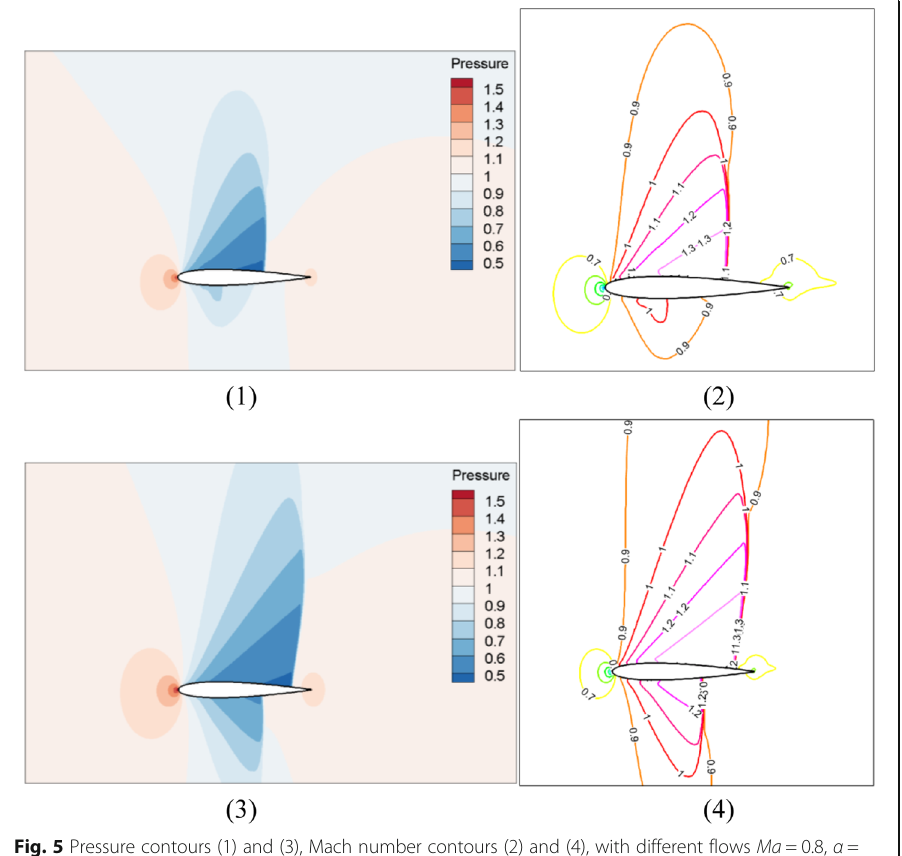
Fig. 5 Pressure contours (1) and (3), Mach number contours (2) and (4), with different flows Ma = 0.8, α =